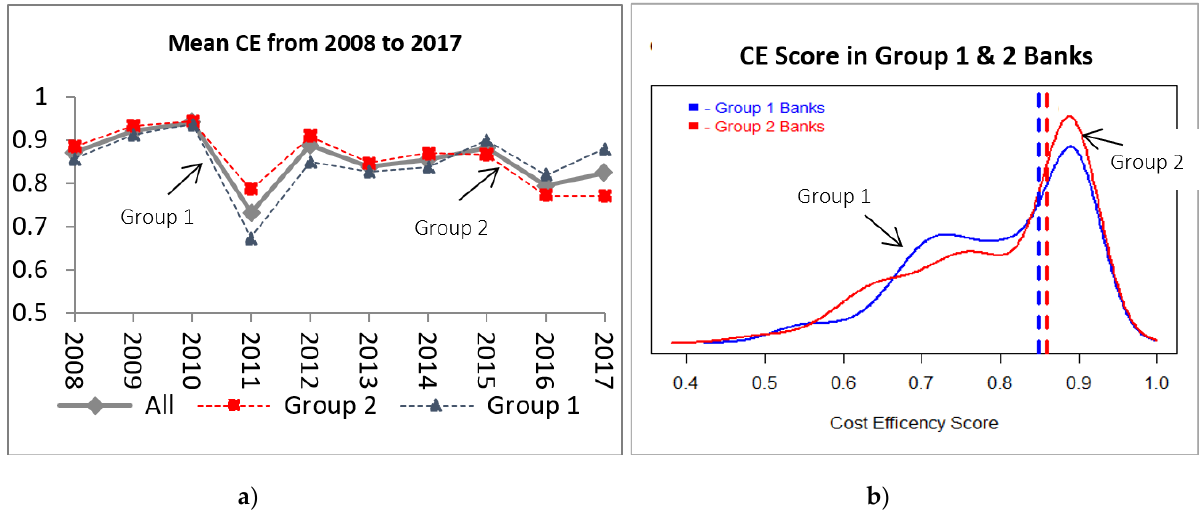
Figure 4. The mean CE scores of Vietnam’s group 1 and 2 banks for the period 2008 to 2017. Notes: CE = cost-efficiency.